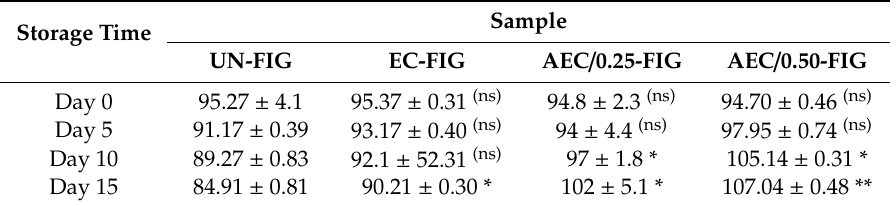
Table 1. Changes in total polyphenol contents (mg Gallic acid equivalent (GAE) / 100 g fresh weight (FW)) occurring after 5, 10, and 15 days of storage at 4 ◦ C with di ff erent packaging.